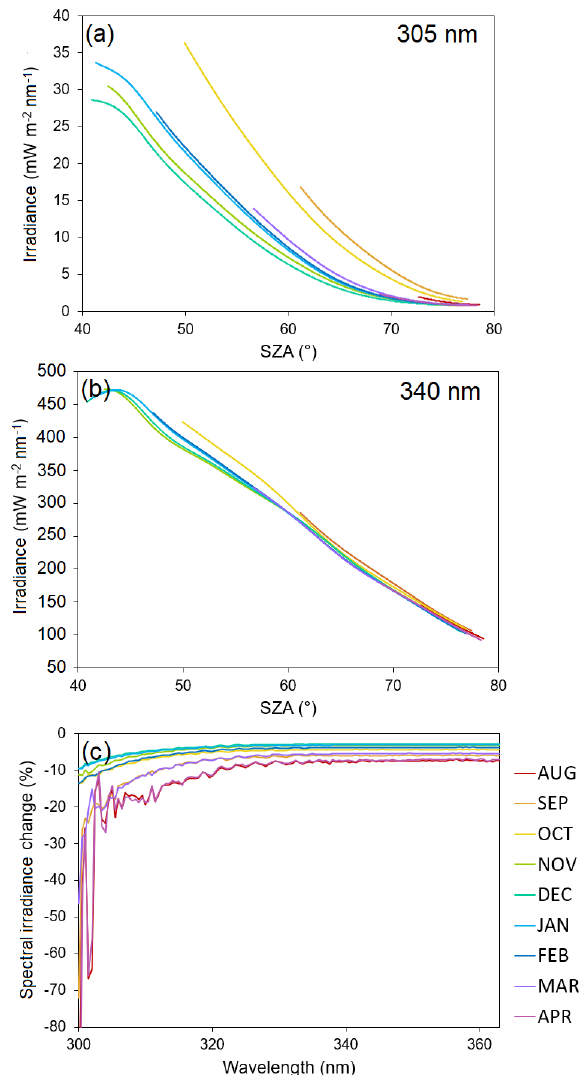
Figure 8. Modeled relationships between UV irradiance and TOC for different months. Panels (a) and (b) show the modeled UV ir- radiance at 305nm (a) and 340nm (b) as a function of TOC. Panel (c) shows the relative change in spectral UV irradiance resulting from an increase in TOC by 10DU, calculated with reference to the monthly median